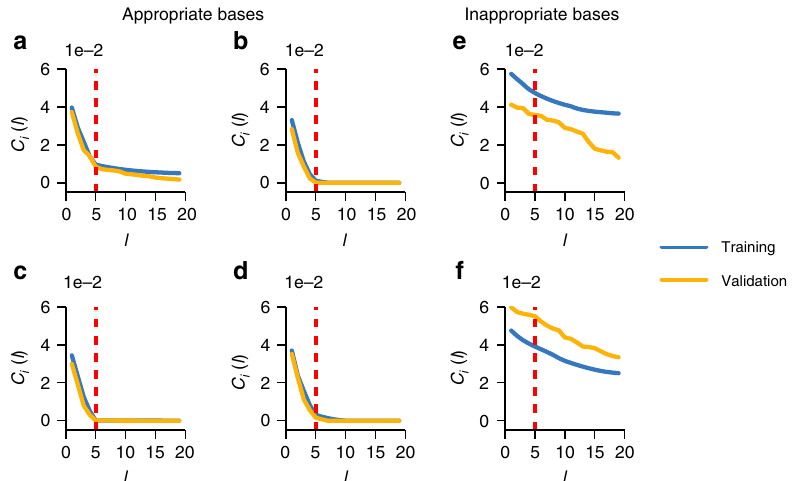
Fig. 5 Learning curves with respect to the number of iterations l reveal appropriate expansions. a – f Learning curves for basis functions shown in Table 1; indices in Table 1 equal panel identi fi cation. The training and validation sets are composed by the 60 and 40% of recordings, respectively. For all basis functions a – d chosen from an appropriate class (here: true pairwise interactions), the curve exhibits an L-shape with a clear plateau starting at the correct number of incoming interactions (vertical dashed line), above adding more interactions reduces the fi tting costs only weakly or not at all. If basis functions are chosen from an inappropriate class ( e , f ), the cost functions decrease only mildly and do not exhibit